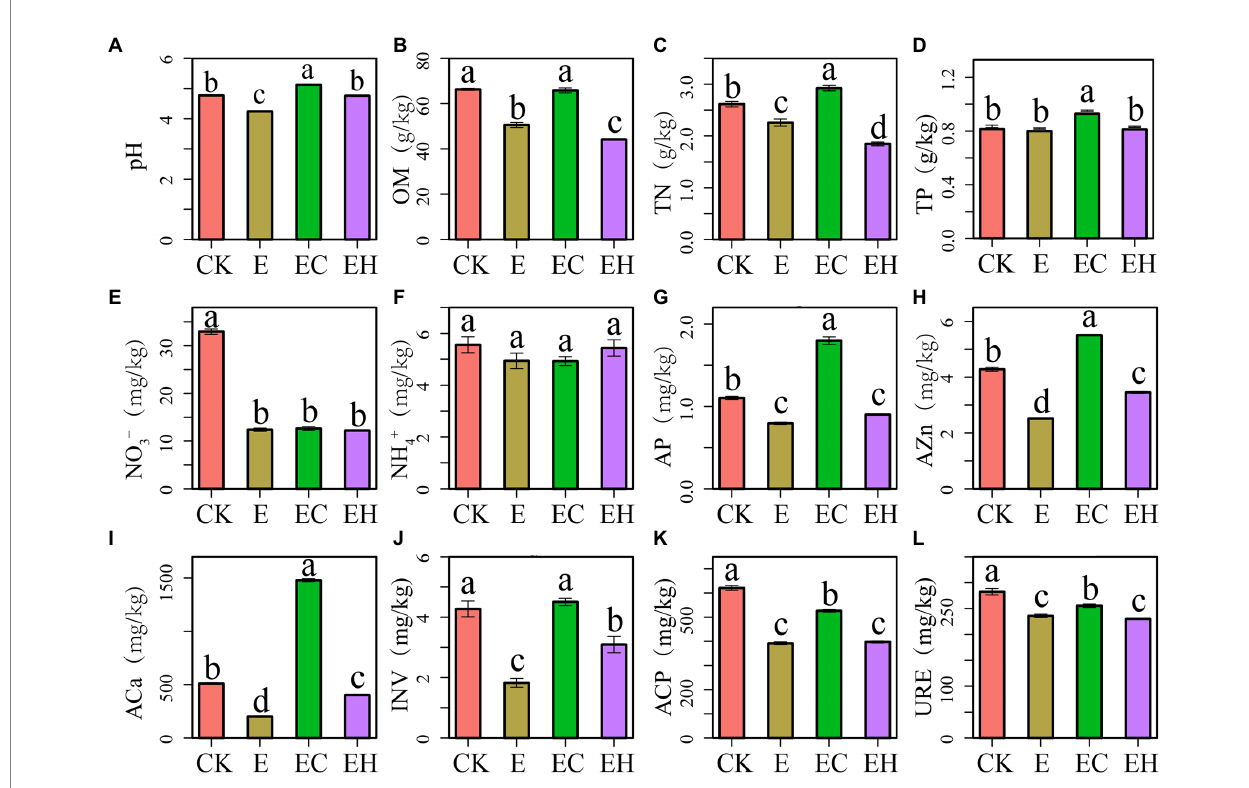
FIGURE 1 Soil chemical properties (A–I) and enzyme activities (J–L) in pure eucalypt plantations (CK, E) and mixed plantations (EC, EH). Different lowercase letters above the bar chart in different colors indicate significant differences at the 0.05 level. CK, the first rotation of E. urophylla plantations; E, the third rotation of E. urograndis plantations; EC, mixed plantations of E. urograndis and Cinnamomum camphora ; EH, E. urograndis and Castanopsis hystrix ; OM, soil organic matter; TN, total nitrogen; TP, total phosphorus; NO¯ 3, nitrate nitrogen; NH+ 4, ammonium nitrogen; AP, available phosphorus; AZn, available zinc; ACa, available calcium; INV, invertase; ACP, acid phosphatase; URE,